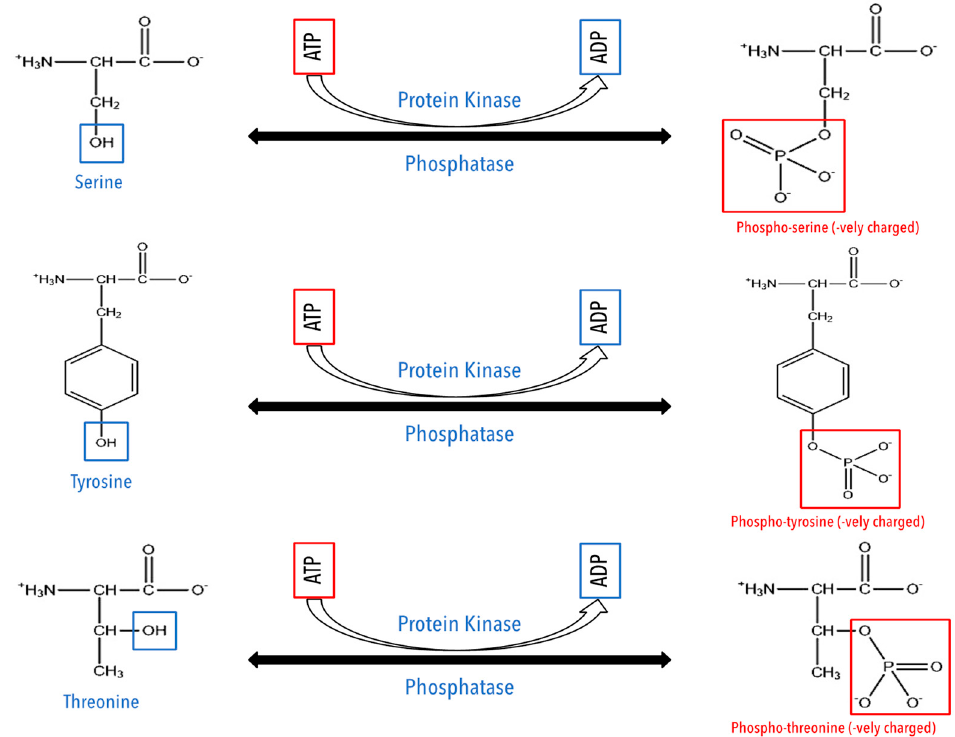
Figure 3. Schematic representation of phosphorylation on multiple amino acids.